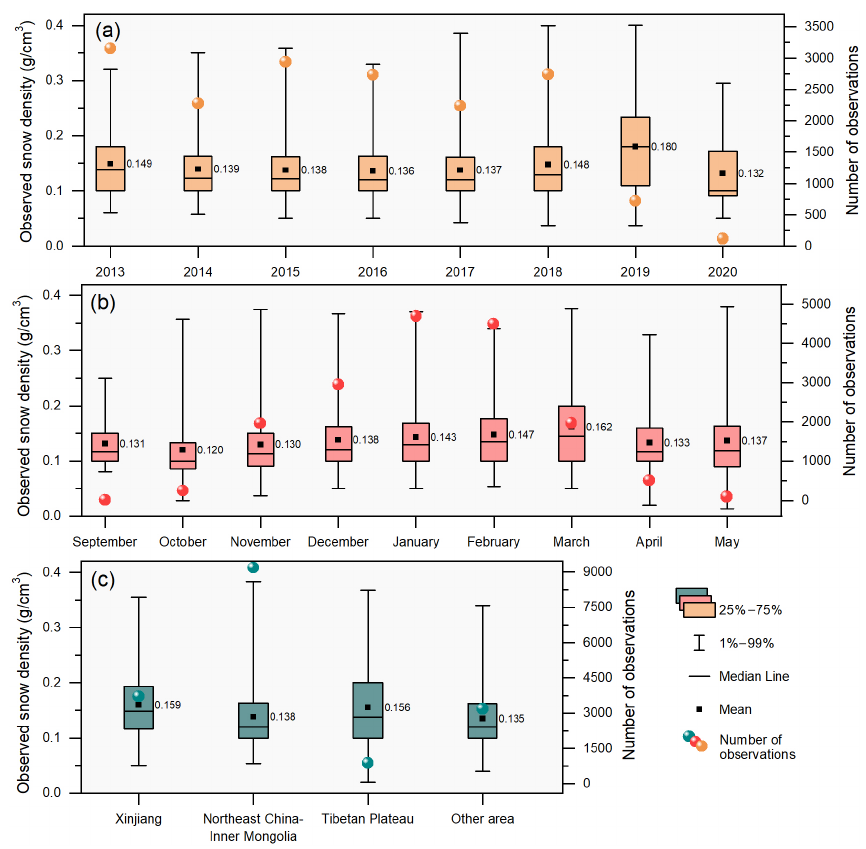
Figure 3. Descriptive statistics of the snow density and the number of ground observations in different years (a) , months (b) , and snow cover regions (c)